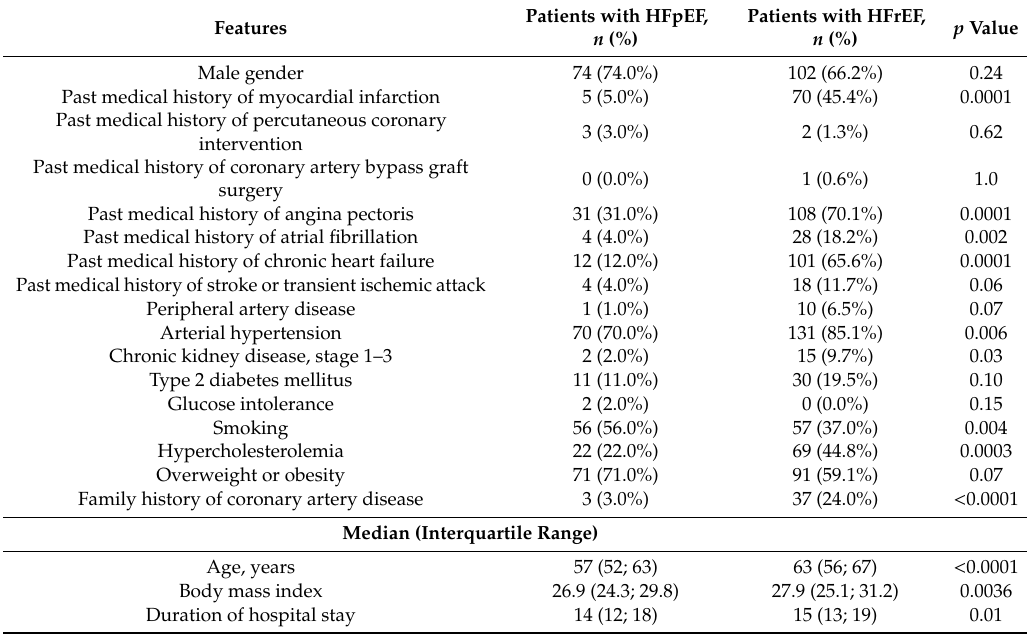
Table 1. Clinicopathological features of the patients diagnosed with ST-segment elevation myocardial infarction with preserved ejection fraction (HFpEF, n = 100) and ST-segment elevation myocardial infarction with reduced ejection fraction (HFrEF, n =